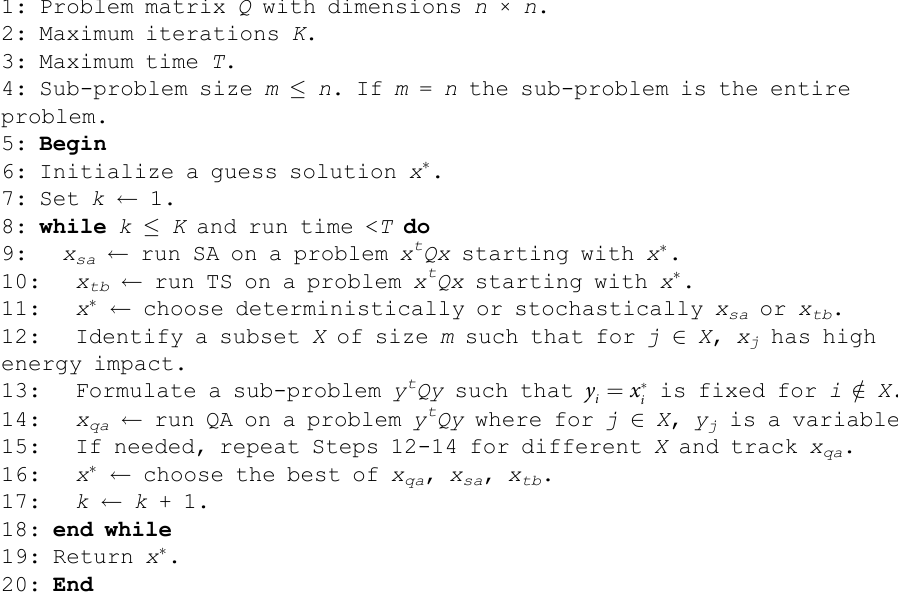
Algorithm 1 The hybrid algorithm runs simulated annealing (SA), tabu search (TS) and quantum annealing (QA) on multiple